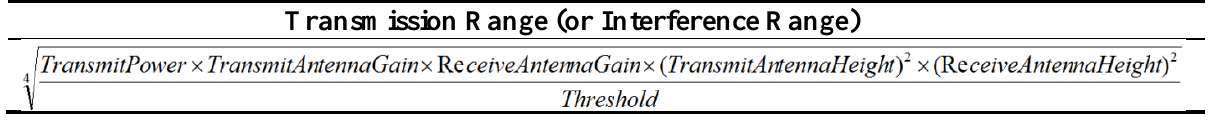
Table 7. Two-Ray Ground Reflection Model.